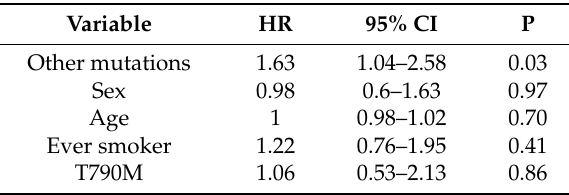
Table 4. Multivariate Cox regression model for